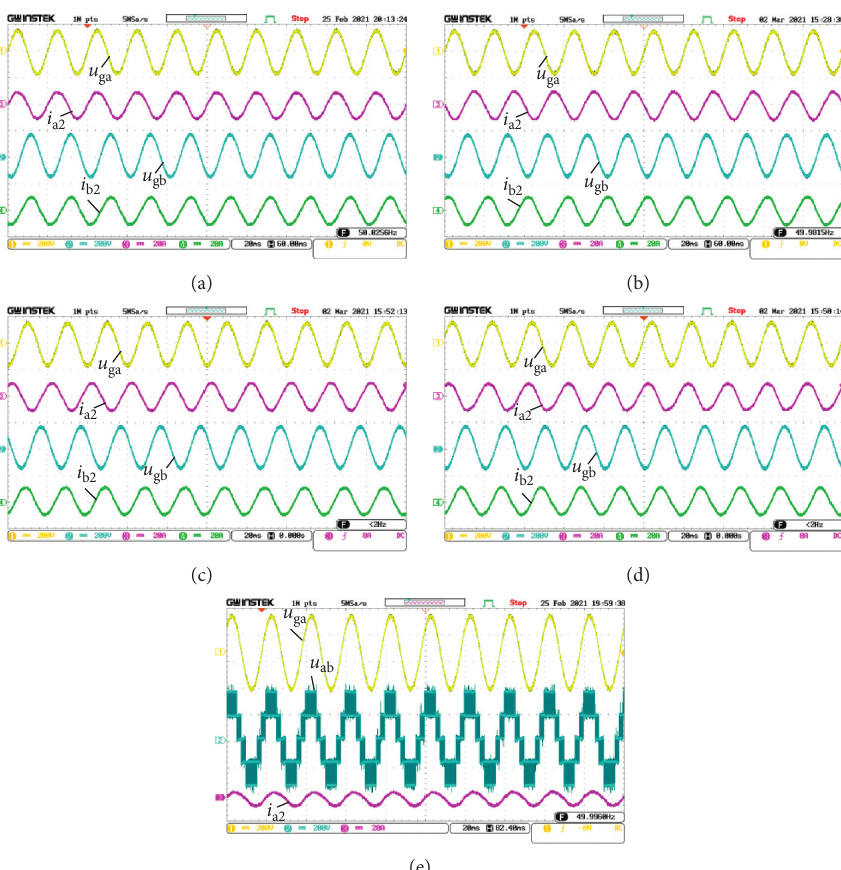
Figure 15: Experimental results of the PCS prototype. (a) Grid voltage and current waveforms in battery-discharging condition (unity PF). (b) Grid voltage and current waveforms in battery-charging condition (unity PF). (c) Grid voltage and current waveforms in battery- discharging condition (|PF| � 0.9). (d) Grid voltage and current waveforms in battery-charging condition (|PF| � 0.9). (e) Output line voltage waveforms of T-type 3L PCS.